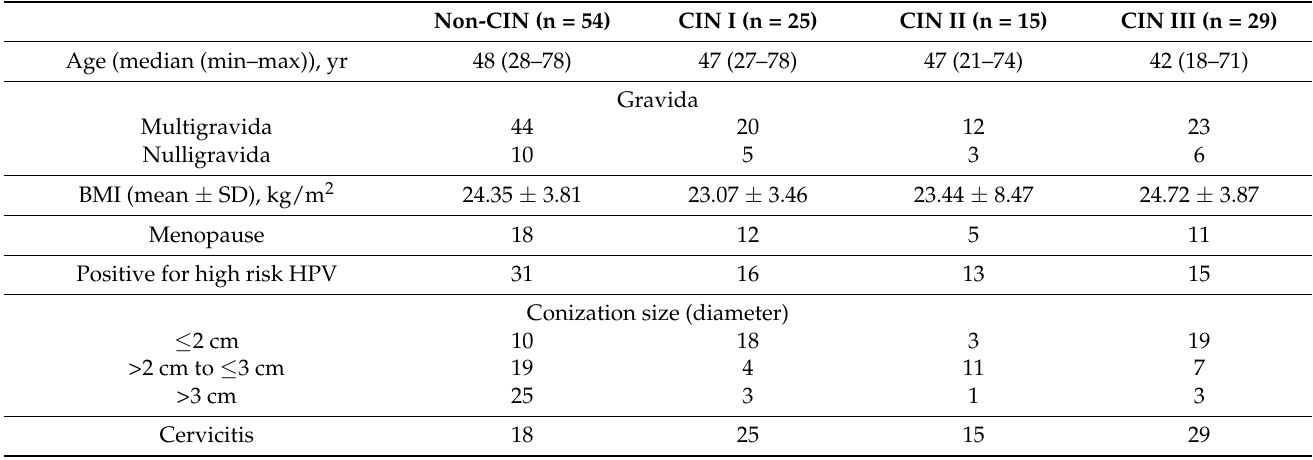
Table 1. Demographic and clinical characteristics of the patients included in this study. Non-CIN (n = 54)